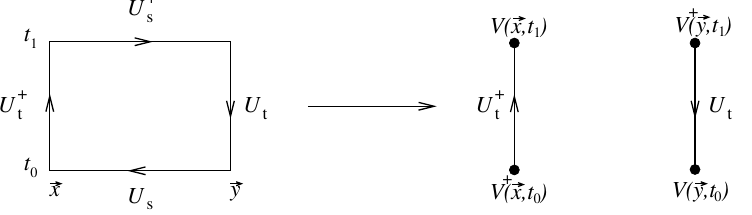
Figure 1. The spatial Wilson lines U s ( (cid:126) x ,(cid:126)y, t ) of the classical Wilson loop W ( R , T ) of size ( R = | (cid:126)y − (cid:126) x | ) × ( T = | t 1 − t 0 | ) (left) can be replaced by Laplacian eigenvector pairs V † ( (cid:126) x , t ) V ( (cid:126)y, t ) (right).